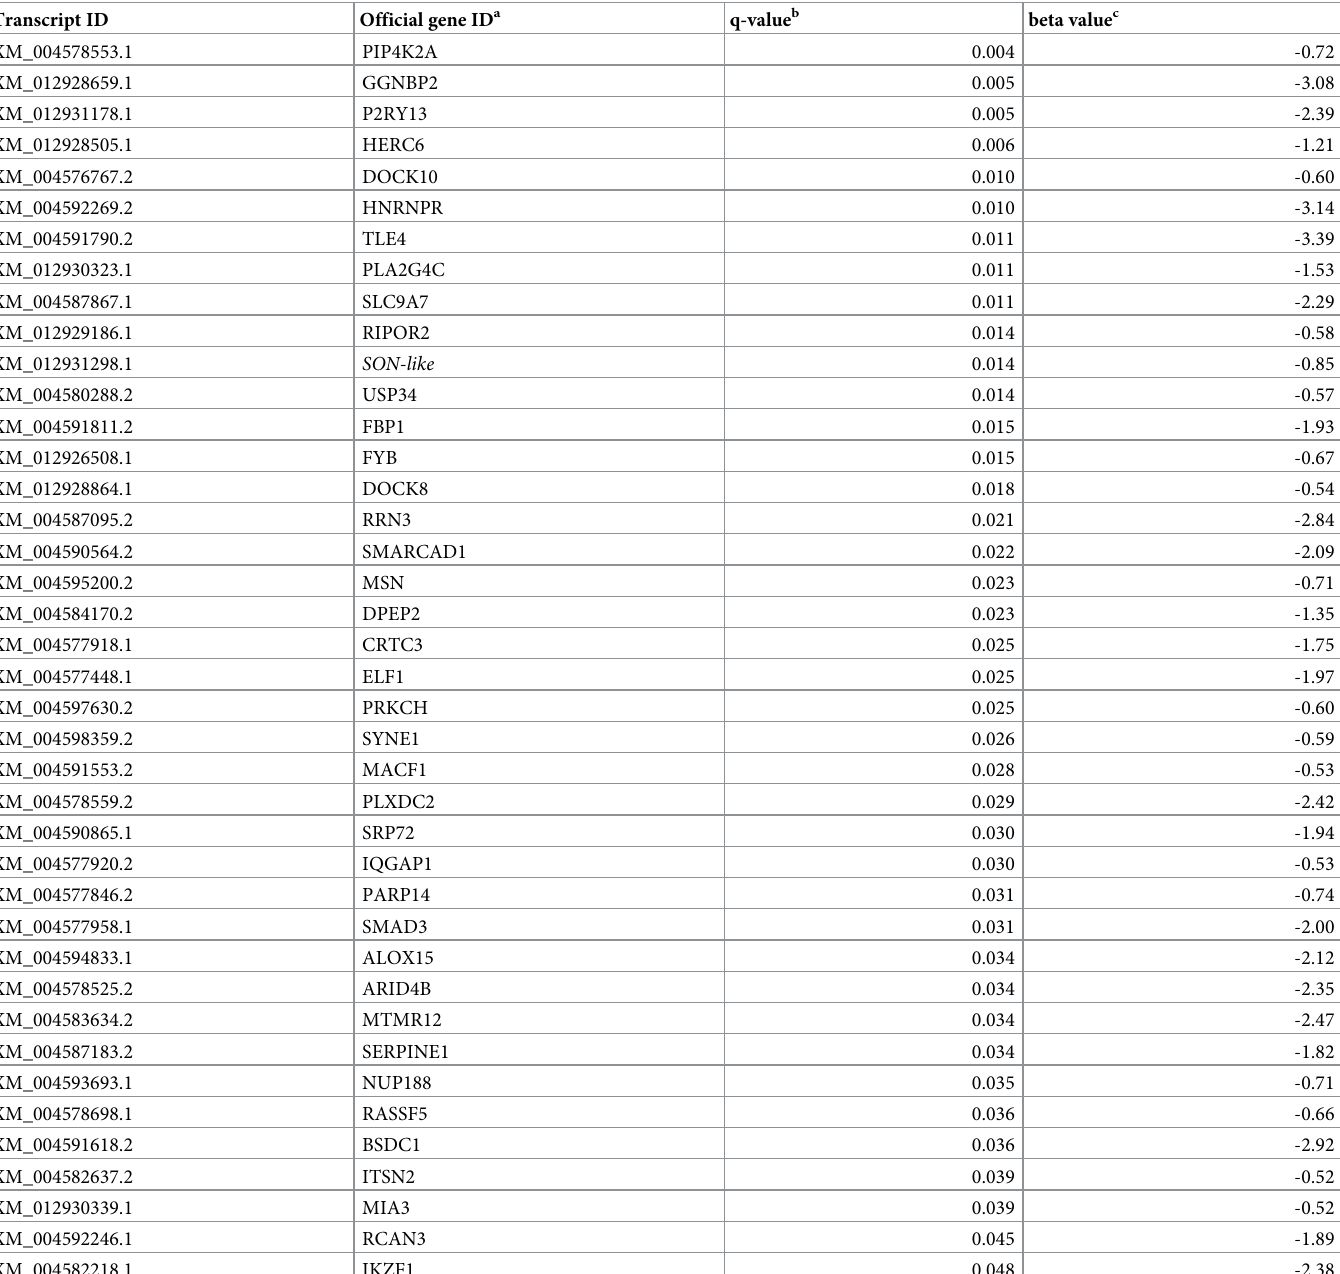
Table 4. Genes down-regulated in the 5,000 m